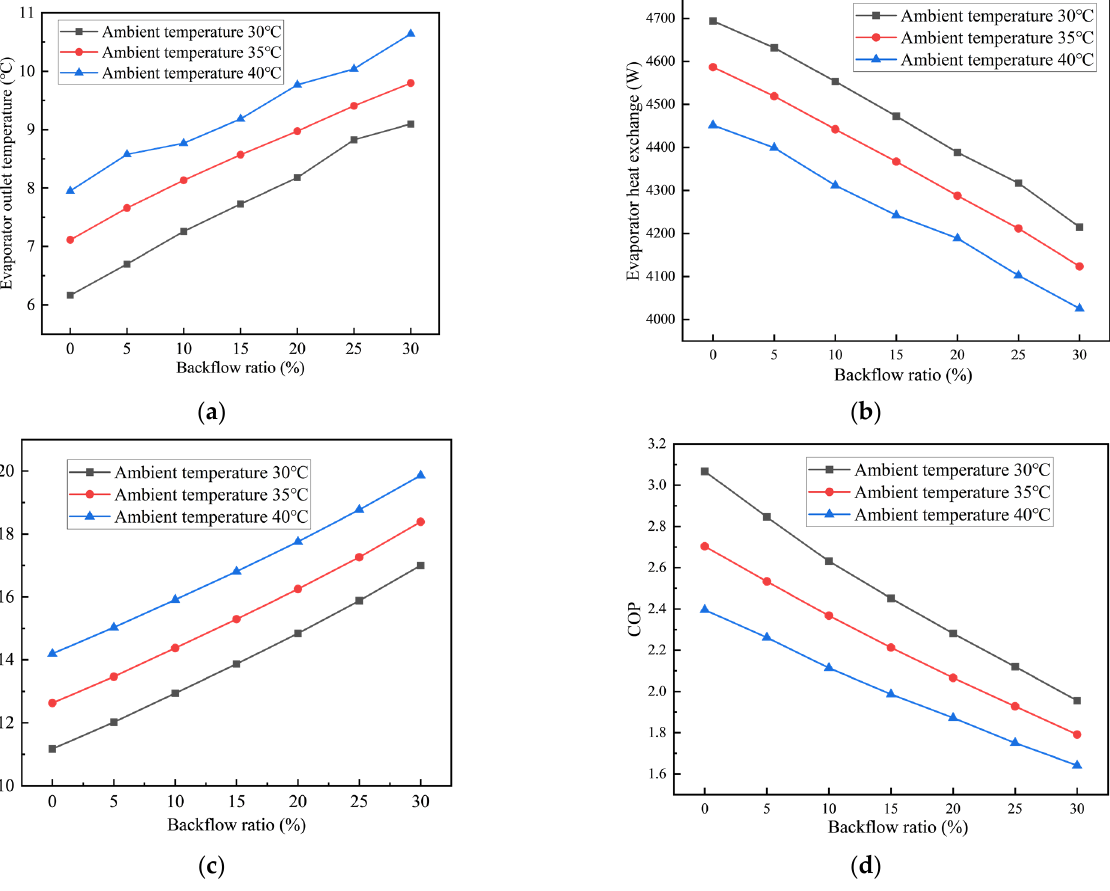
Figure 7. Influences of backflow rate on air conditioning performances under different ambient tem- peratures. ( a ) Evaporator outlet temperature; ( b ) evaporator heat rejection; ( c ) compressor discharge pressure; and ( d ) COP.